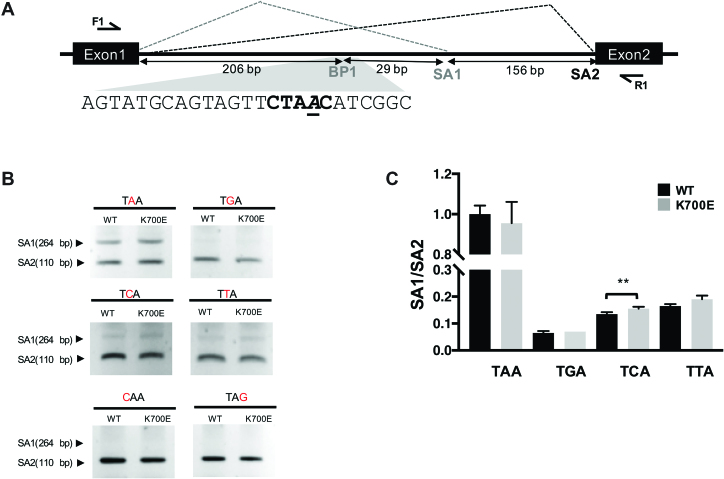
Minigene splicing assay to determine change in isoform ratios of SA1 and SA2 utilization with variation of BP sequence. (A) Minigene with canonical BP sequence CTAAC highlighted. BP adenosine is underlined. Two splice sites SA1 and SA2 are marked. Location of primers for amplification of minigene transcript are also shown (arrow). (B) Agarose gel electrophoresis of minigenes with different BP substitutions. Amplification of isoform that utilizes SA1 produces a 264 bp product while amplification of SA2 results in a 110 bp product. Top and middle panels show control vector (TAA) and variations at −1 position (TGA, TCA, TTA). Lower panel shows additional variants (C at −2 position or replacing the BP adenosine by G). (C) Quantitative PCR of isoforms that utilize SA1 or SA2 (using junction-spanning isoform-specific primers). Ratio of SA1 use to SA2 use was calculated for each minigene, the SF3B1WT value was normalized to 1. Error bars represent SEM of three replicates. ** represents P value < 0.02 by Student's t-test.